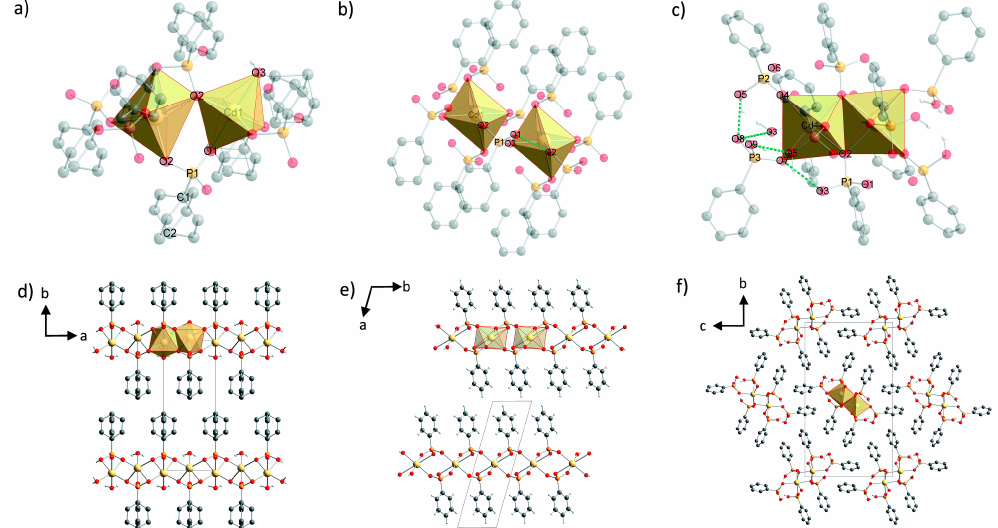
Figure 9. Molecular structure and coordination polyhedra for the Cd 2 + ions and hydrogen bonds (green dashed lines) of ( a ) Cd(O3PPh)·H 2 O, ( b ) Cd(HO 3 PPh) 2 , ( c ) Cd(HO 3 PPh) 2 (H 2 O 3 PPh), and the crystal structures of Cd(O 3 PPh)·H 2 O, ( d ) viewed along the c -axis, ( e ) Cd(HO 3 PPh) 2 , viewed along the c -axis, and ( f ) Cd(HO 3 PPh) 2 (H 2 O 3 PPh), viewed along the a -axis. Hydrogen atoms of the phenyl rings are omitted for clarity. Colour code: yellow: cadmium, orange: phosphorus, red: oxygen, grey: carbon, light grey: hydrogen. Adapted with permission from reference [56]. Copyright 2016, Royal Society of